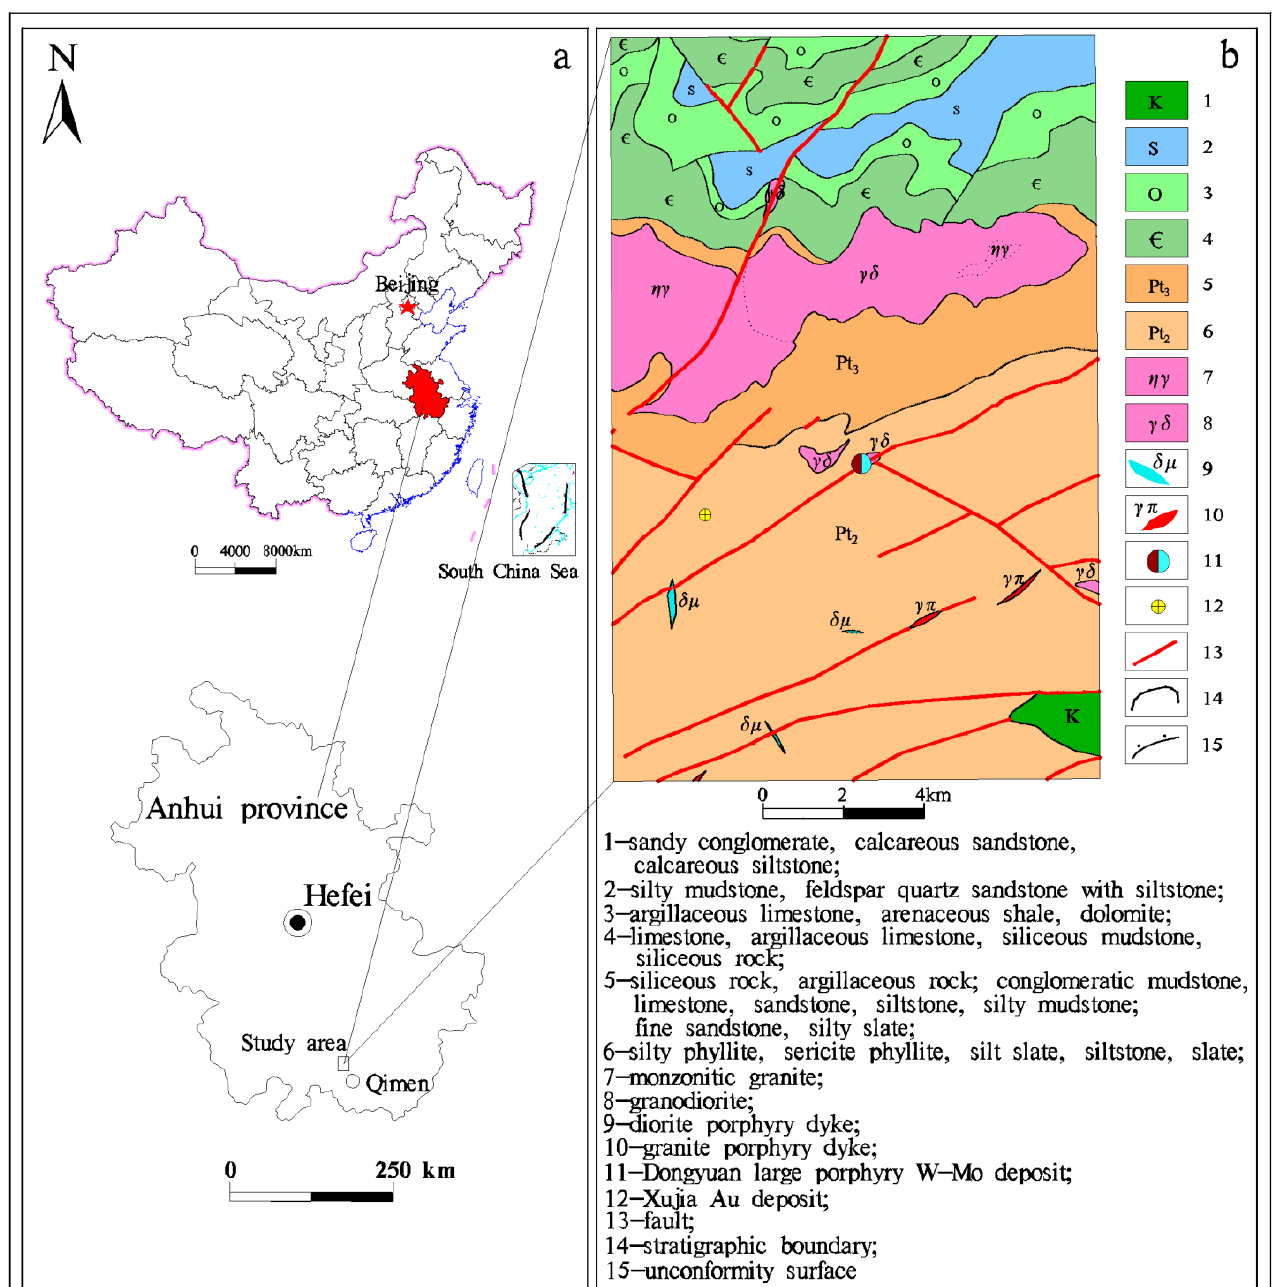
Figure 1. Geographical location ( a ) [43] and geological ( b ) map of the study area.